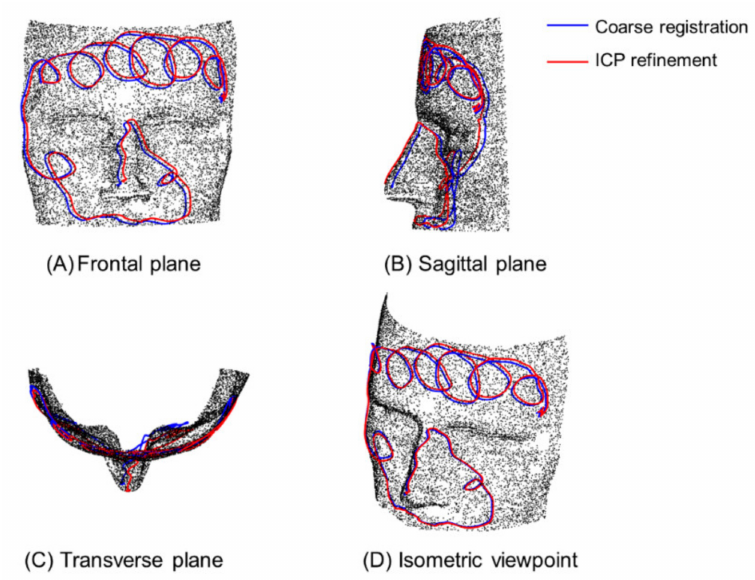
Figure 7. Coarse registration (representative trial) ( A – D ).